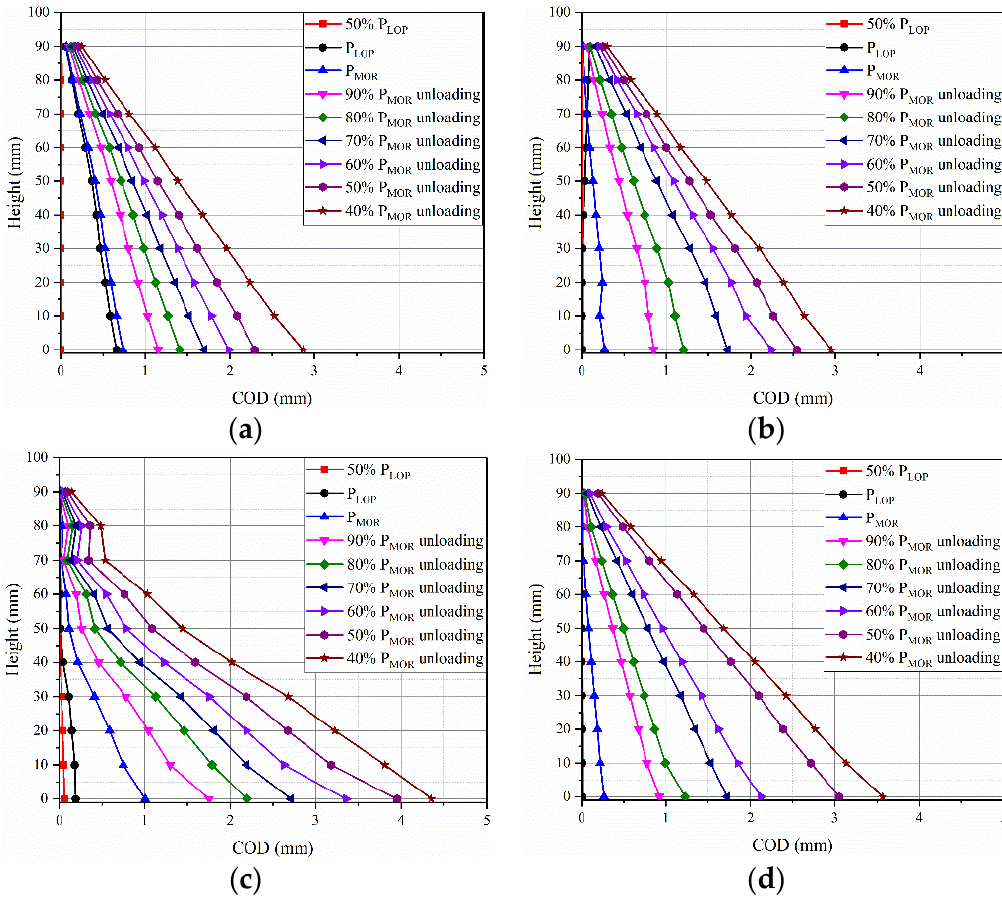
Figure 9. COD evolution in fracture tests with perpendicular orientation in F0.25U ( a ), F0.5U ( b ), F0.75U ( c ), and F1U ( d ). The maximum value of COD for F0.25, F0.5U, F0.75U, and F1U is 2.87 mm, 2.95 mm, 4.36 mm, and 3.56 mm, respectively. It is further shown that increasing the thickness of the steel fiber layer can effectively imprint the propagation behavior of FRCM. This result is matched with the results of